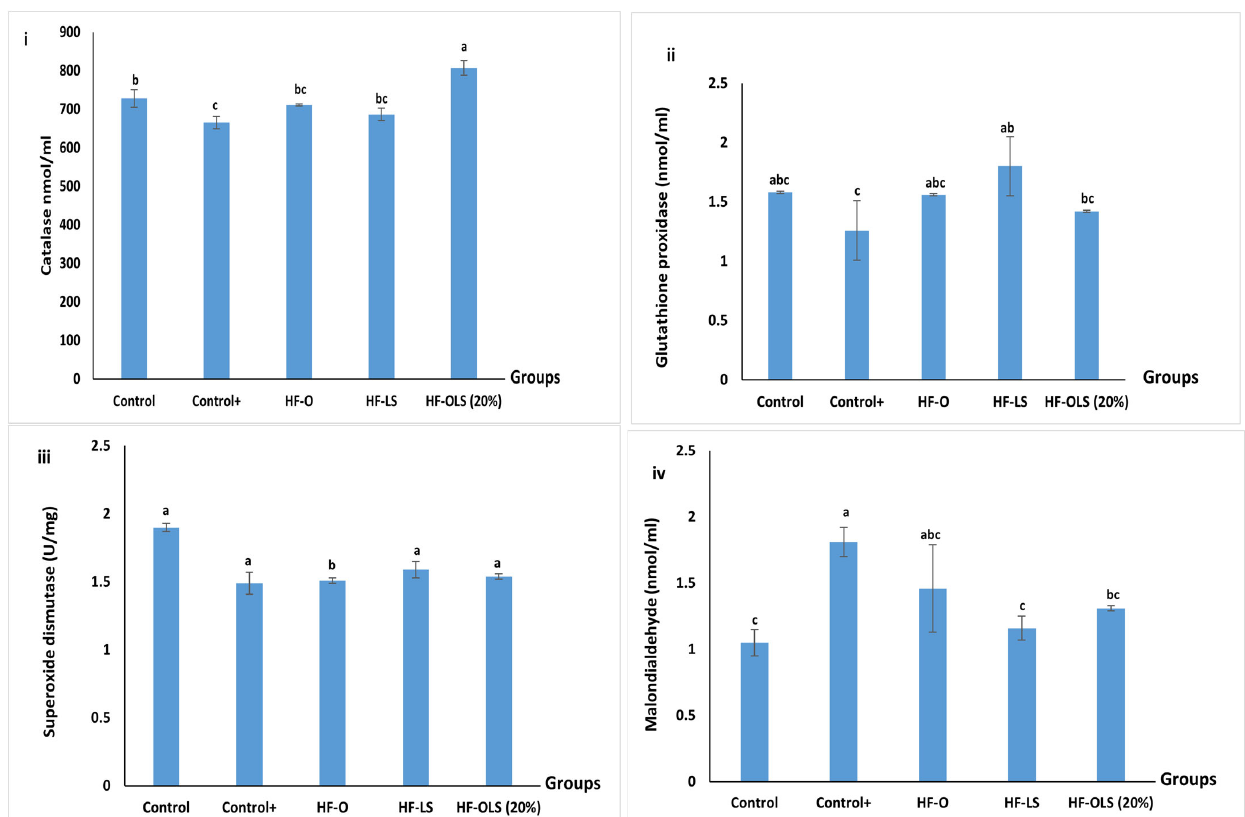
Figure 10. Oxidant and antioxidant enzymes of rats fed with standard diet, high fat diet, and high fat diet and juice for three months. ( i ): catalase (mmol/mL), ( ii ): glutathione peroxidase (mmol/mL), ( iii ): superoxide dismutase (U/mg), and ( iv ): malondialdehyde (mmol/mL). Control (rats fed with a standard diet), Control+ (rats fed with a high-fat diet composed by mixing a standard diet with 20% of vegetarian ghee), HF-O (rats fed with a high-fat diet and 9 mL/kg/day of orange juice), HF-LS (rats fed with a high-fat diet and 9 mL/kg/day of beetroot leaf–stem juice), HF-OLS (20%) (rats fed with a high-fat diet and 9 mL/kg/day of orange juice mixed with 20% of beetroot leaf–stem juice). Columns labeled with different letters are significantly different at p <